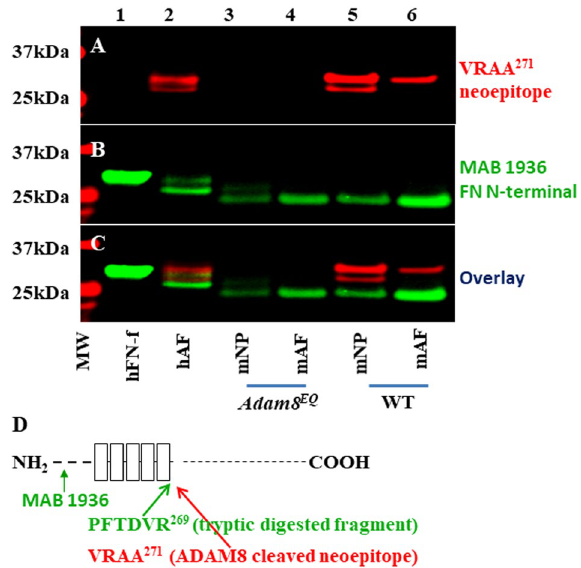
Figure 1. ADAM8 cleaves fibronectin, and Adam8 EQ mutation abrogates its enzymatic activity. MW molecular weight markers; Lane 1: human plasma FN-f (control); Lane 2: hAF, human annulus fibrosus (AF) tissue lysate (control); Lanes 3&4: mouse nucleus pulposus (mNP) & mAF from Adam8 EQ mice; Lanes 5&6: mNP and mAF tissues from wild type (WT) mice. ( A ) membrane probed with an antibody recognizing the FN neoepitope (VRAA; shown in red); ( B ) probed with monoclonal antibody (MAB) 1936 recognizing the FN N-terminal domain (shown in green); ( C ) panels ( A , B ) superimposed. ( D ) schematic drawing of the FN-f resulting from trypsin or ADAM8